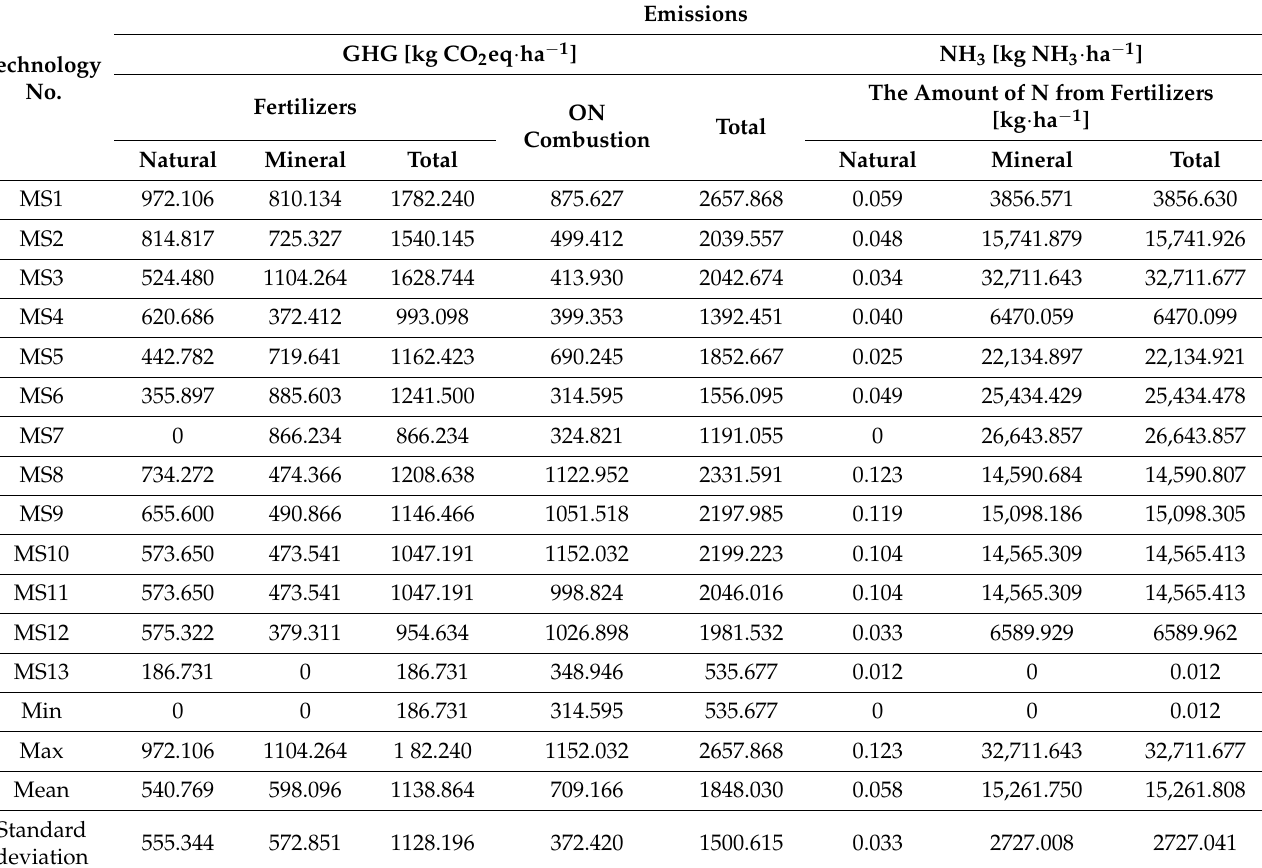
Table 6. GHG and NH 3 emissions for the technologies under study per area unit